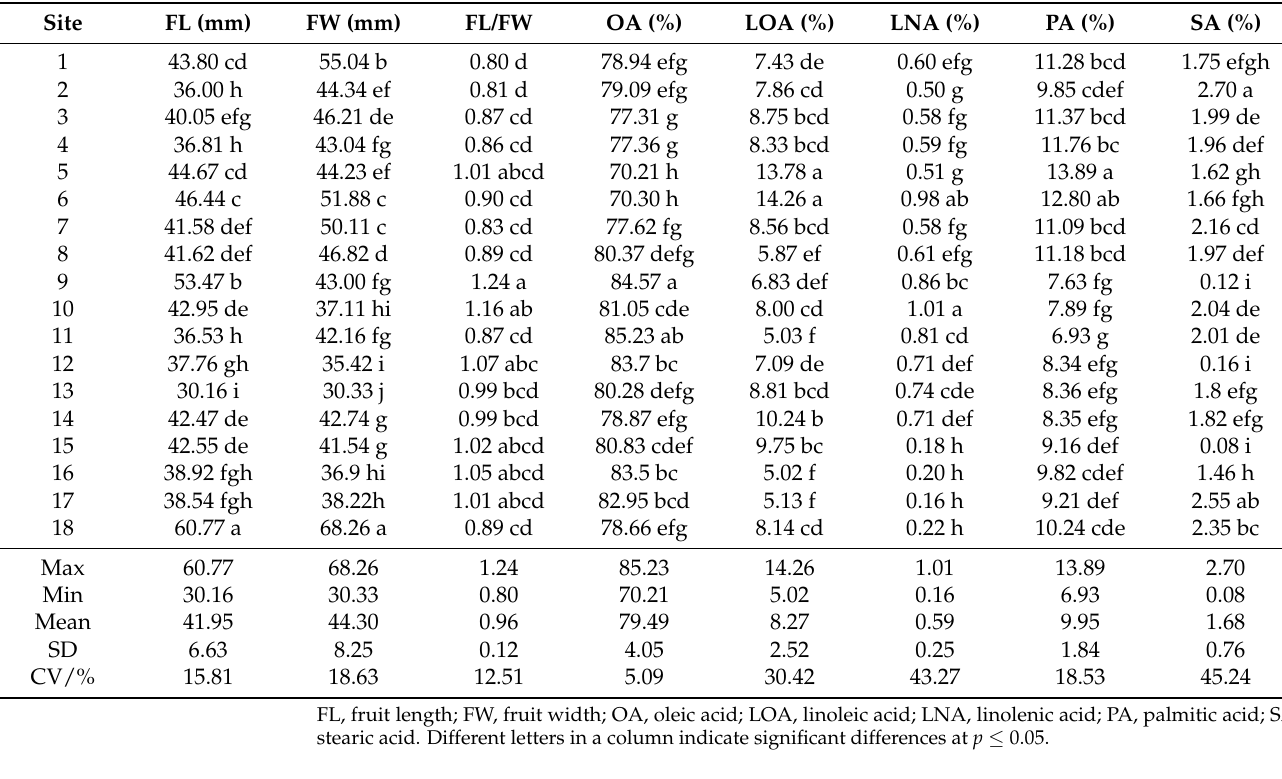
Table 2. Statisticaldataoffruitmorphologyandfattyacidcompositionof18populationsof Camellia oleifera .